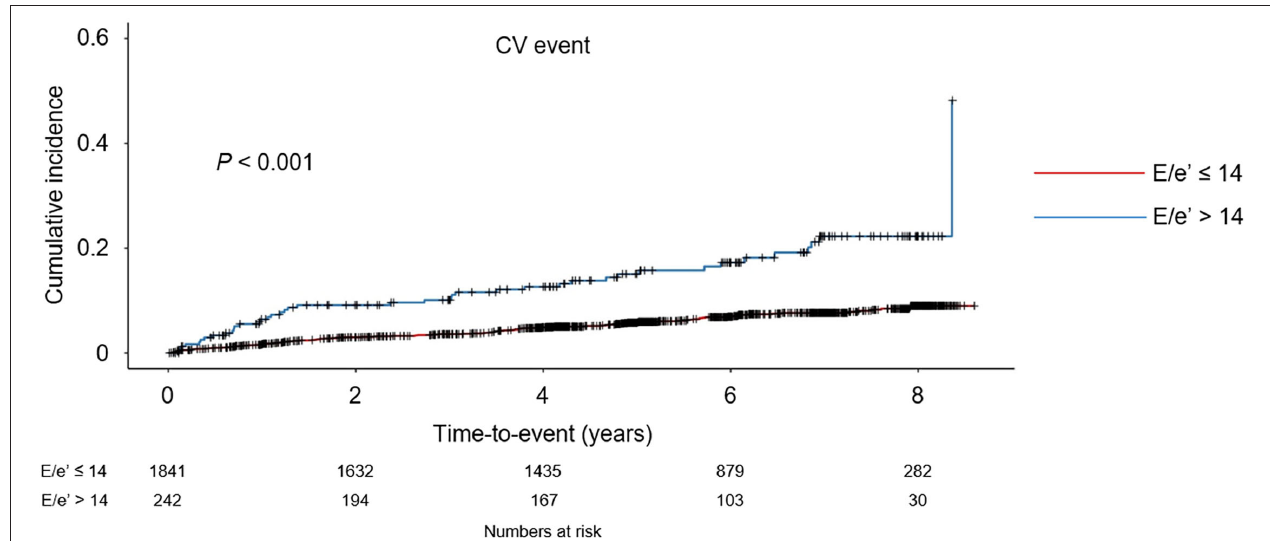
FIGURE 2 | Kaplan-Meier analyses of cardiovascular (CV) event-free survival by E / e ′ . CV event-free survival curve is depicted. P -value determined using log-rank test. E / e ′ , ratio of the early transmitral blood flow velocity to early diastolic velocity of the mitral annulus.